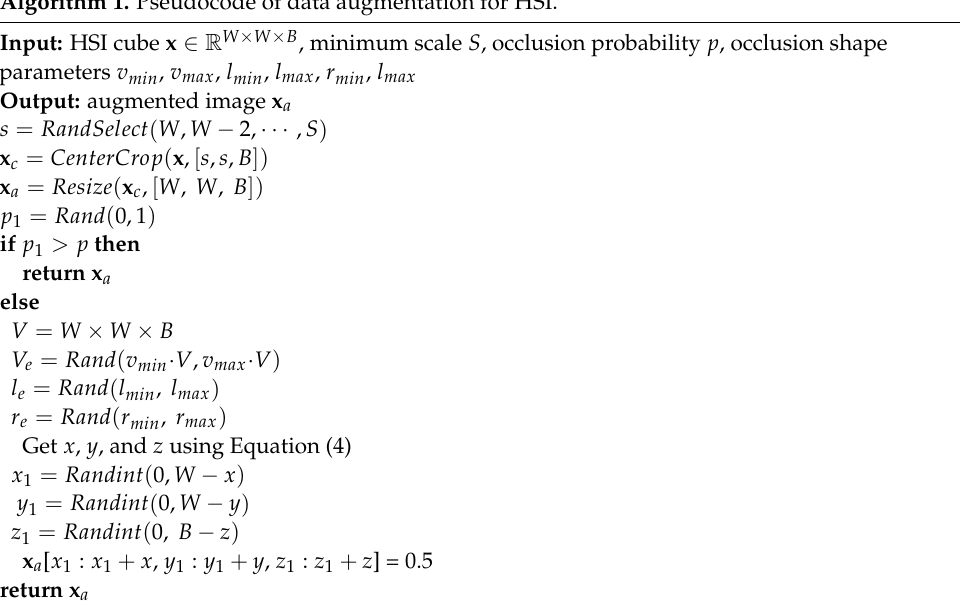
Algorithm 1. Pseudocode of data augmentation for Algorithm 1 Pseudocode of data augmentation for HSI